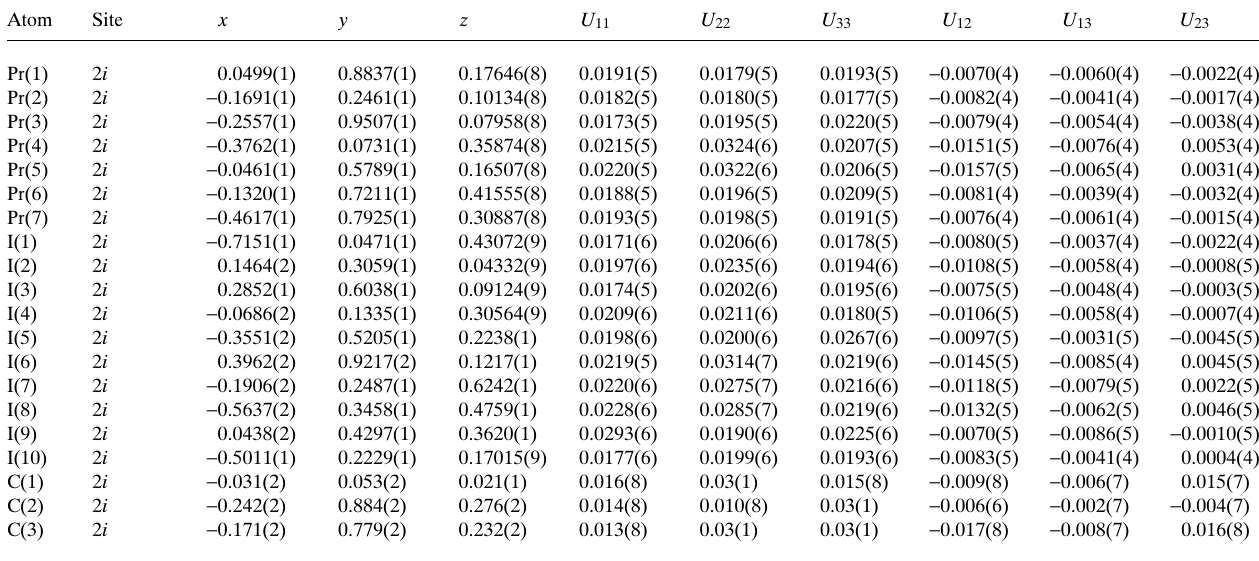
Table 2. Atomic coordinates and displacement parameters (in Å 2 ) .